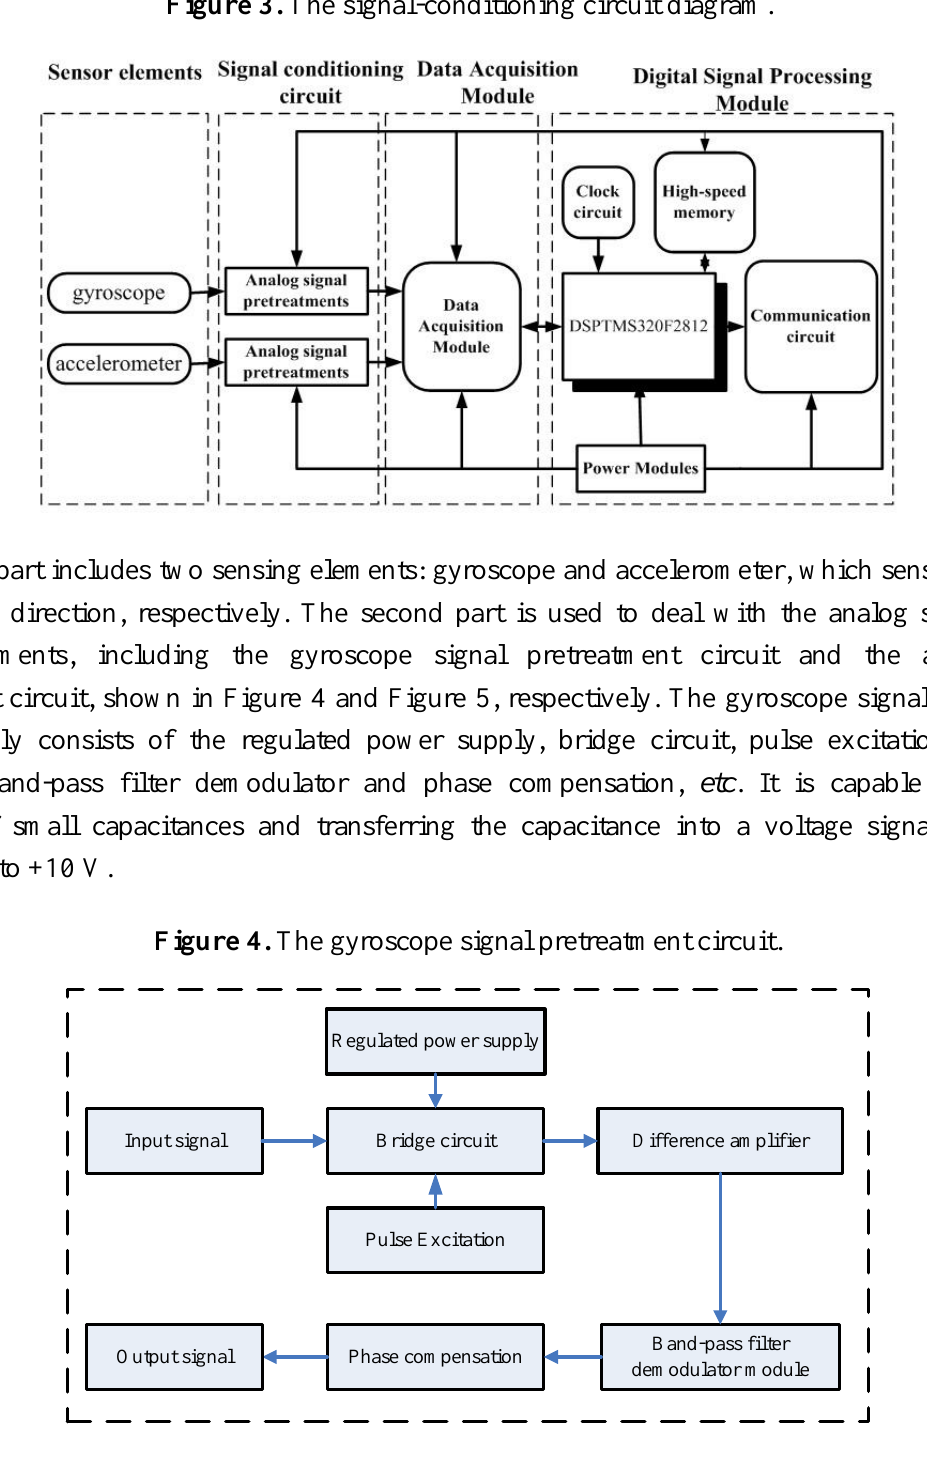
Figure 3. The signal-conditioning circuit diagram.